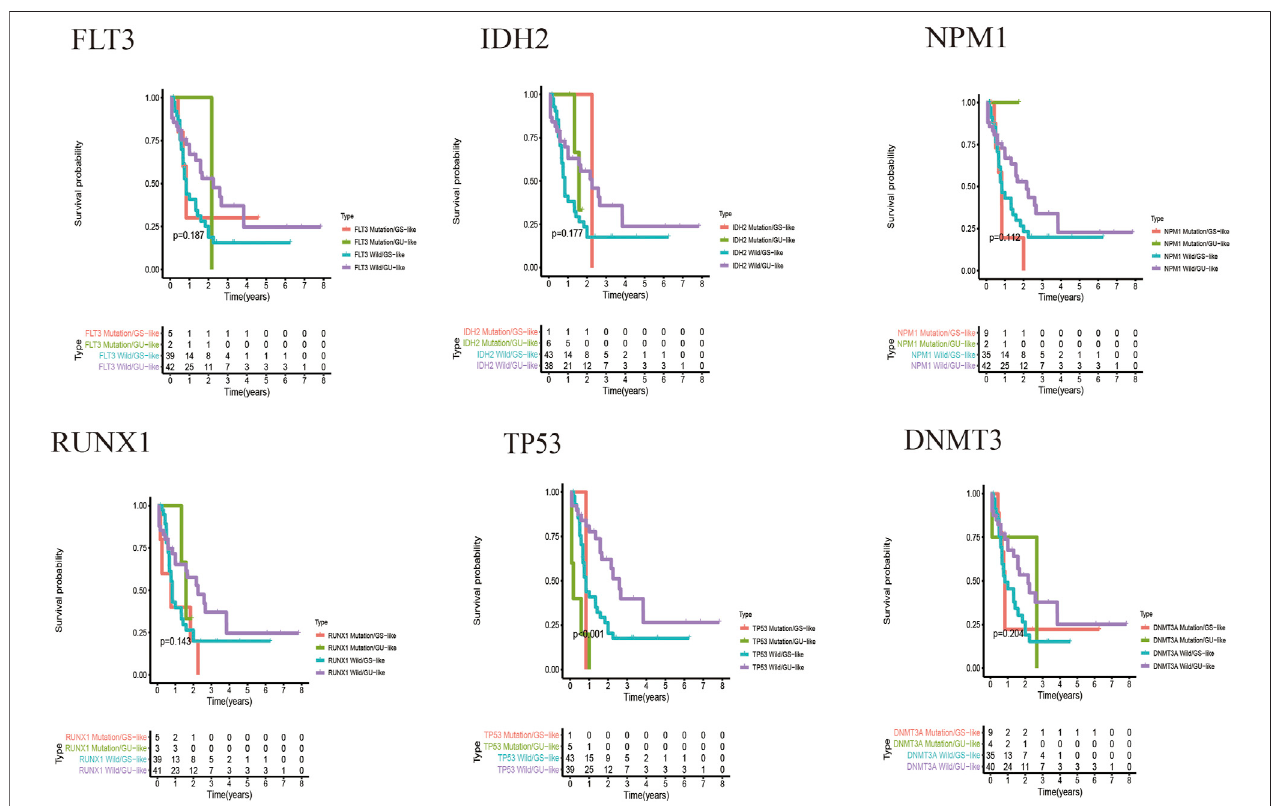
FIGURE8| Kaplan – Meiercurvesofthegenomicstabletypeandgenomicunstabletypeunderdifferentgenemutations.The X -axisrepresentstime,andthe Y -axis represents survival probability.